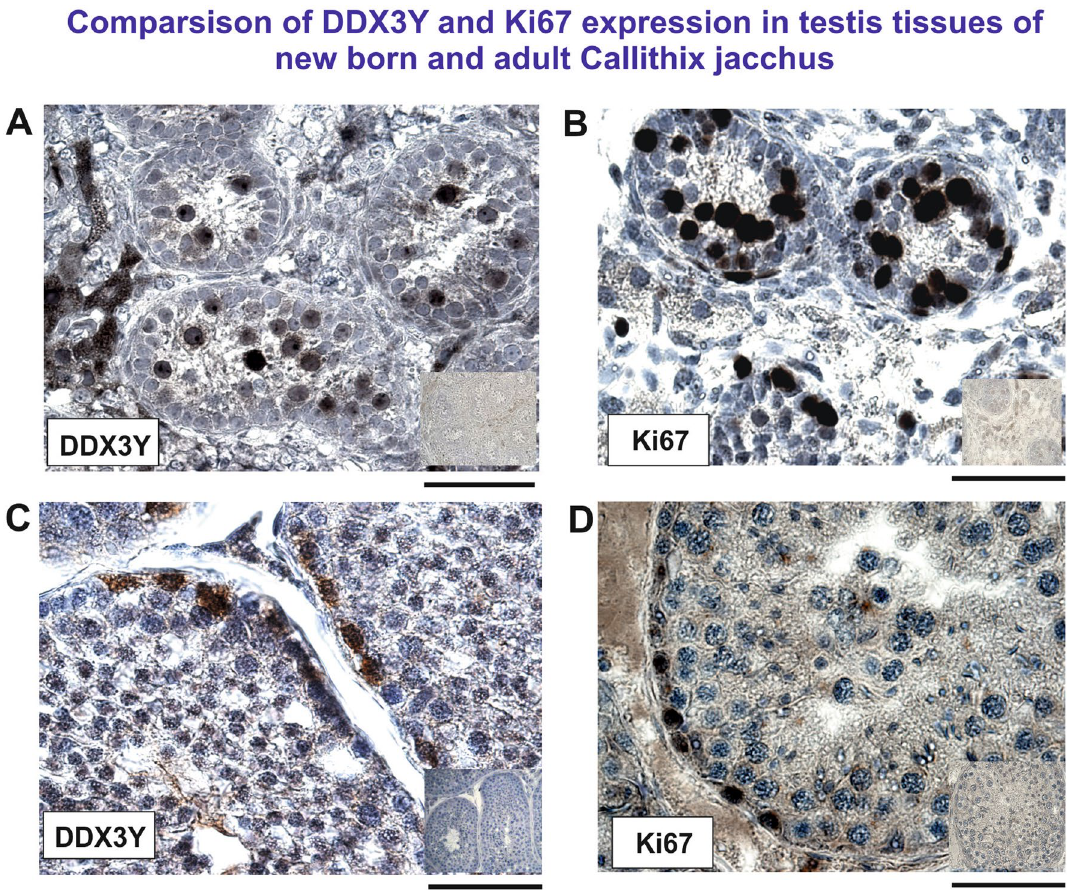
Figure 4. Immunohistochemical staining pattern of DDX3Y expression ( A, C ) and Ki67 expression ( B, D ) in testis tissue of newborn ( A, B ) and adult ( C, D ) Callithrix jacchus. It points to strong proliferation of gonocytes and pre-spermatogonia mainly located in the luminal region of the testis tubules during the new born phase of this new world monkey (A, B) . Adult Callithrix jacchus testis tissue displayed DDX3Y expression mainly in germ cells located at the basal lamina. Ki67 expression is found in the same germ cells at the basal lamina ( C, D ). Small insert pictures always at the right display immunostaining patterns with pre-immune serum on serial sections from the same testis tissues specimen. Scale bars: 50 µm.